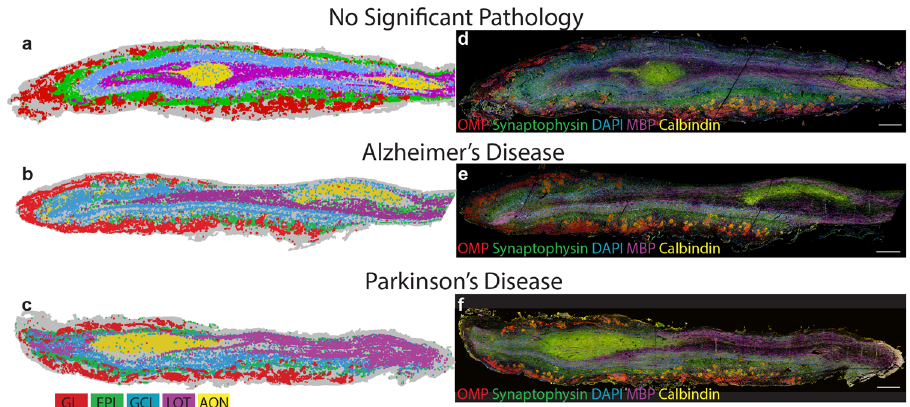
Fig. 4 Olfactory bulb layer signatures determined by individual section cluster analysis are consistent between cases. For each section, clusters were assigned to one of fi ve layers (glomerular layer, GL; external plexiform layer, EPL; granule cell layer, GCL; lateral olfactory tract, LOT; or anterior olfactory nucleus, AON) based on visual inspection of the slide plot. The markers with the highest z-score of labelling intensity were noted for all clusters within a layer and the most conserved markers for each layer were determined to be the layer signature. The clusters with highest expression of signature markers for each layer are overlaid for one representative NSP ( a ), AD ( b ) and PD ( c ) case. The clusters have been pseudo-coloured by layer. The immunolabelling for one signature marker from each layer is also presented ( d – f ). The layer signature is consistent between cases and disease groups. Scale bars 500 μ m ( a – f ).